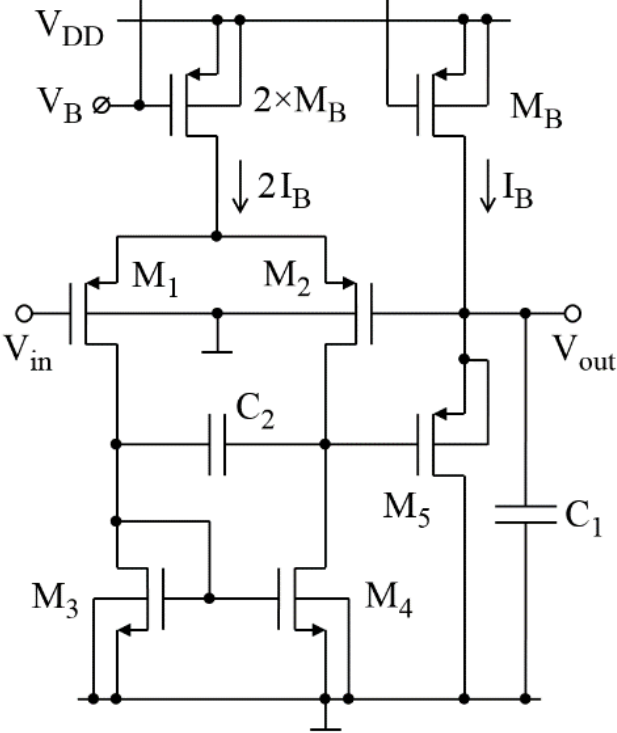
Figure 5. The 0.4-V biquadratic filter obtained on the basis of the ladder prototype in Figure 1a. C 1 , C 2 and I B are 9.2 pF, 8.7 pF, and 250 pA, respectively, assuming Butterworth approximation and f − 3dB of 100 Hz.